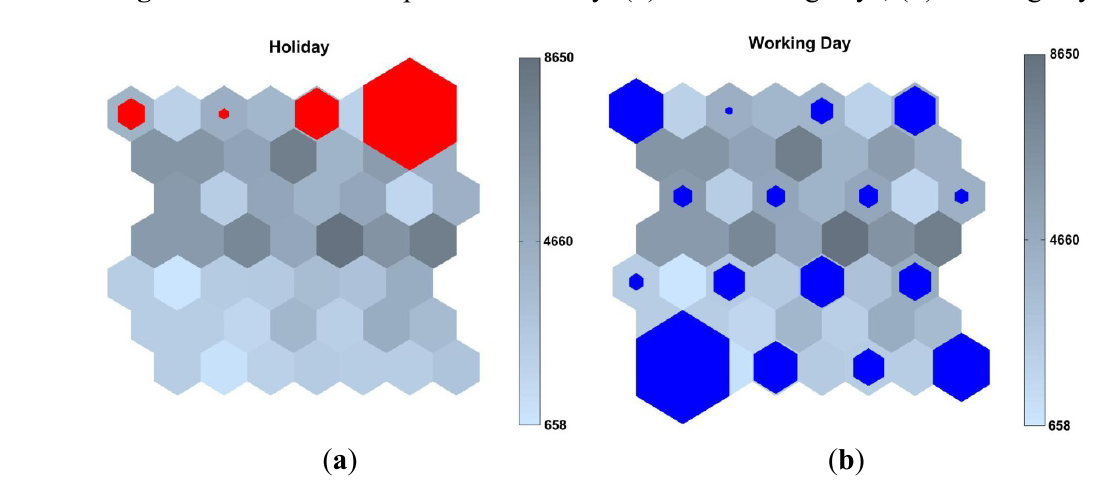
Figure 4. Activation map for workability: ( a ) non-working days; ( b ) working days.